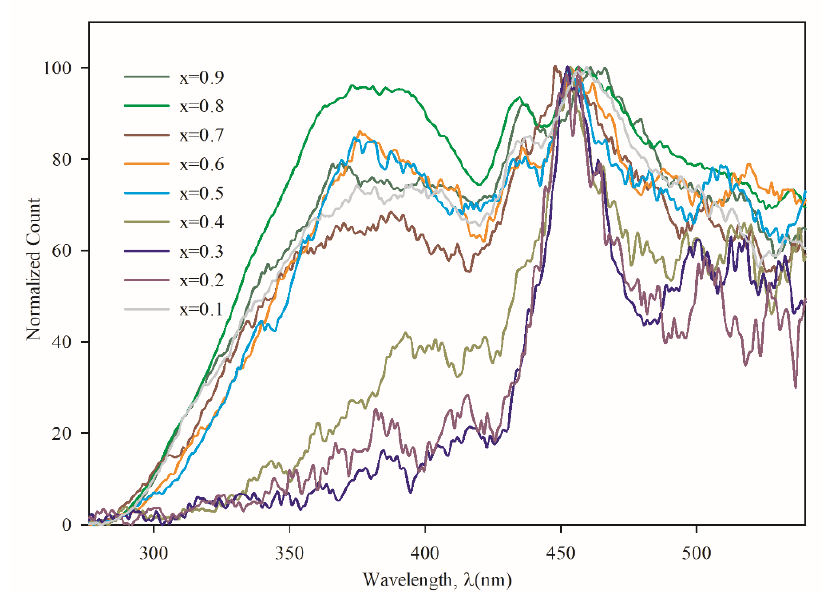
Figure 9. Photoluminescence graph of Zn 1-x Mg x S thin films (0.1 ≤ x ≤ 0.9).